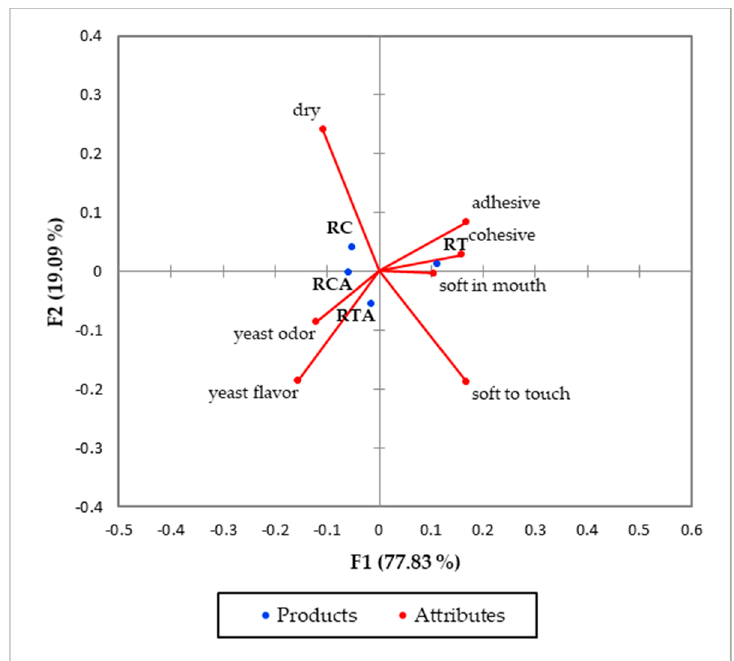
Figure 5. Correspondence Analysis of flat breads with different